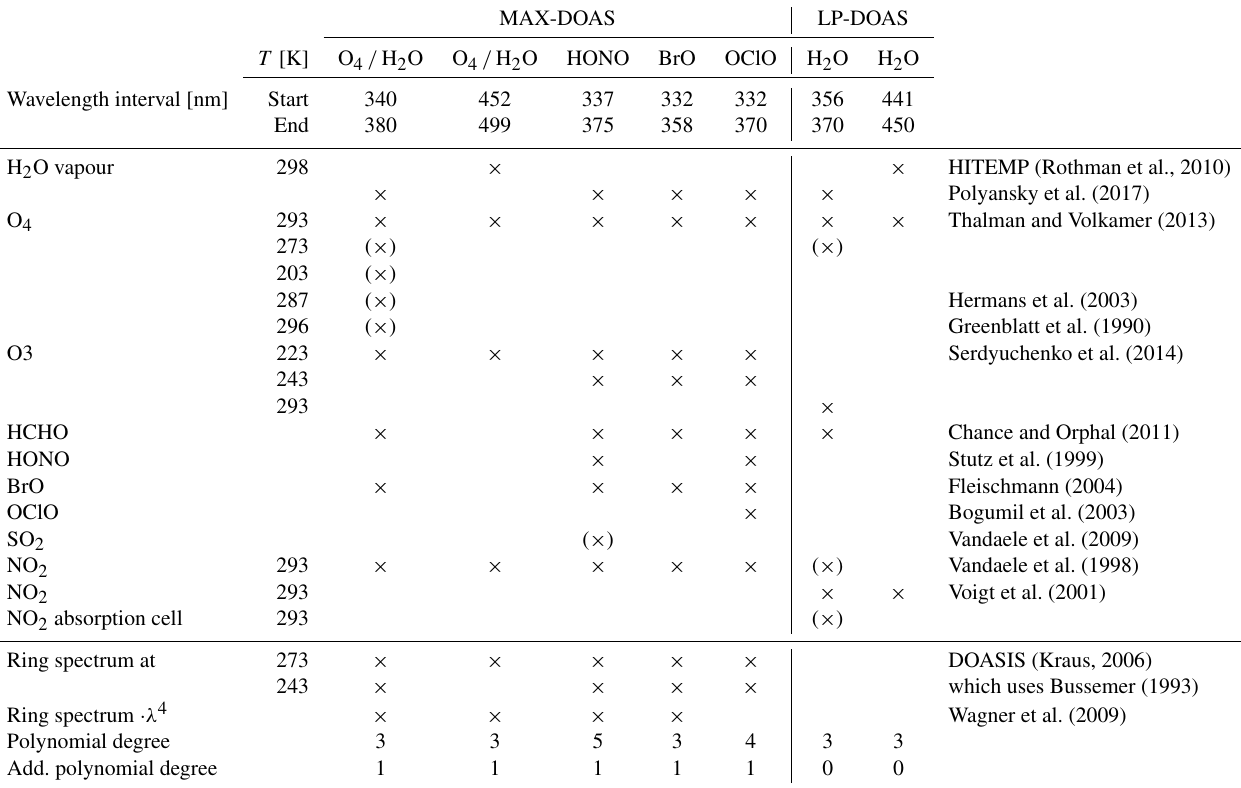
Table 2. Retrieval wavelength intervals and reference spectra for the MAX-DOAS and LP-DOAS measurements. Literature cross sections listed in brackets were used for sensitivity